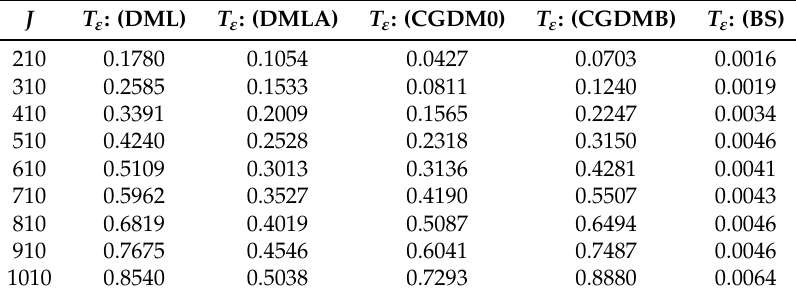
Table 17. Results for Case LG with m = 25, ε = 10 − 2 .